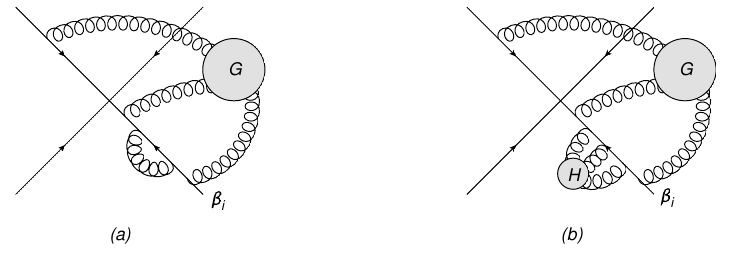
Figure 5 . ( a ) General web diagram containing a self-energy loop, where the rest of the diagram G consists of a number of connected pieces; ( b ) generalisation to include a non-trivial subdiagram H in place of the self-energy